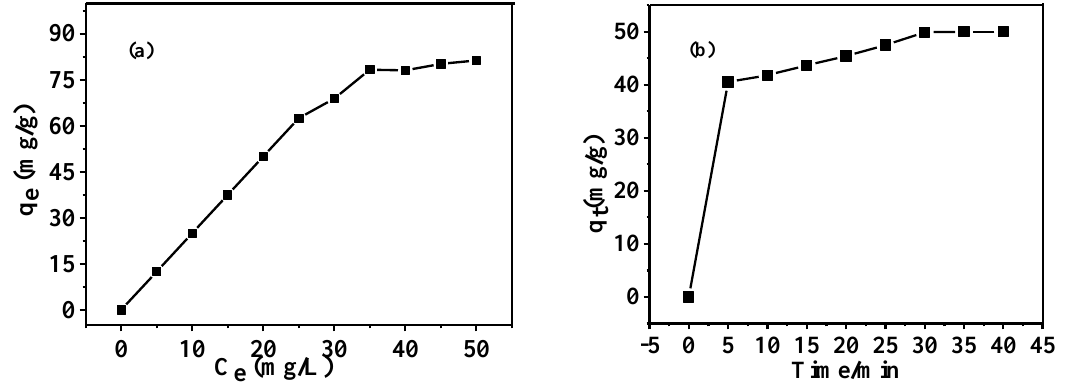
Figure 12. Adsorption isotherms ( a ) and adsorption kinetics ( b ) of HGCS prepared at 900 °C for 3 h with 1.0% Fe catalyst. Table 1. Kinetics parameters of Langmuir and Freundlich models in the case of MB adsorption. Samples